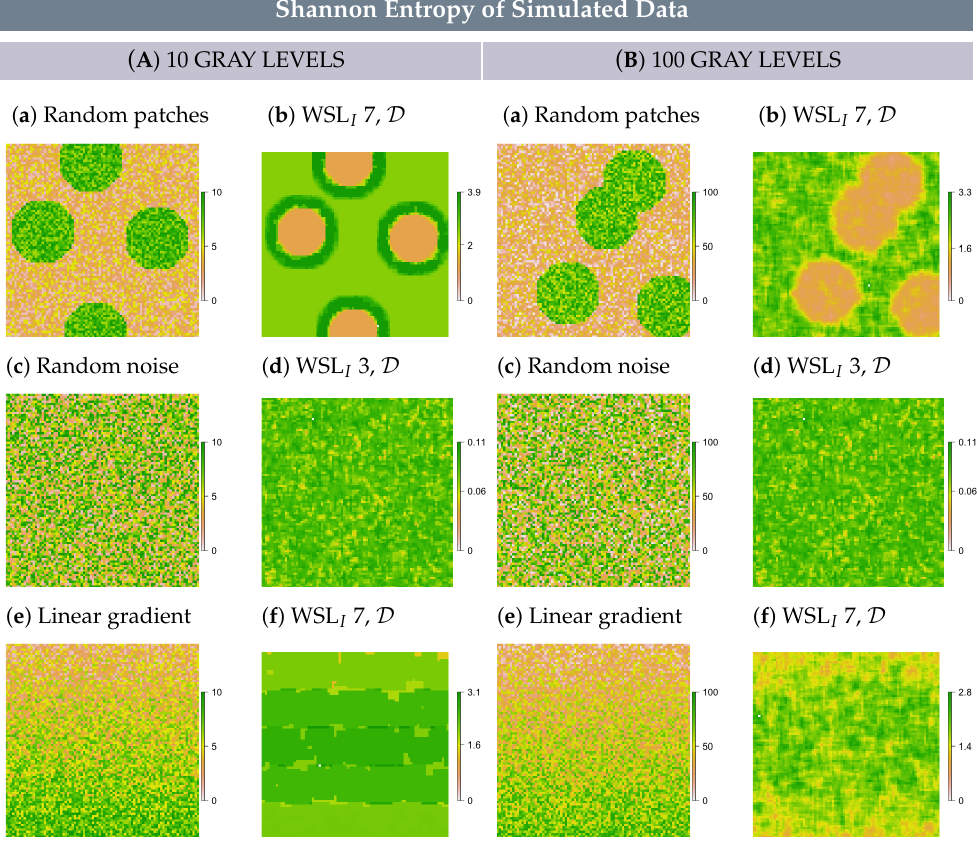
Figure 2. Simulated data: ( A , B ) ( a ) random patches, ( c ) random noise, ( e ) linear gradient data. Structural diversity of ( b ) random patches, ( d ) random noise, ( f ) linear gradient data. The outer scale is the domain, D , in all cases, the inner scale is defined by WSL I . Structural diversity entropy with δ = 0 was employed in all